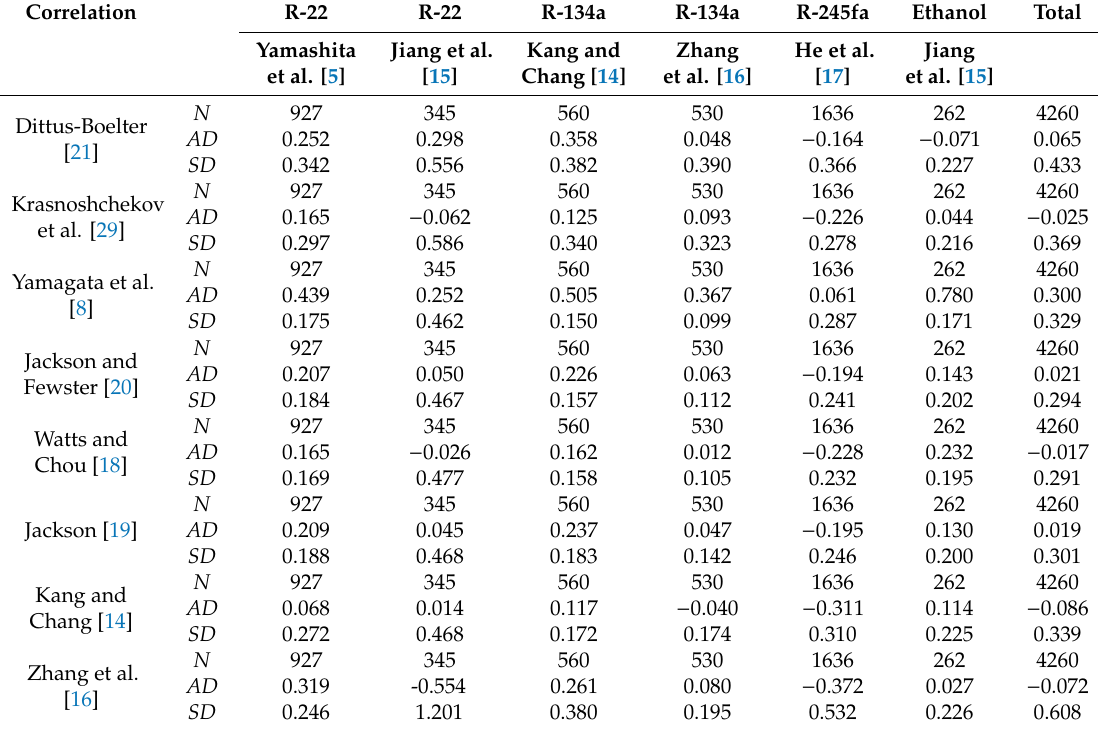
Table 7. Comparisons between the experimental data and the